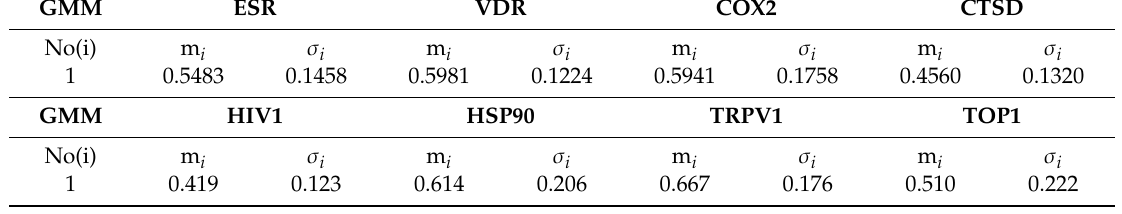
Table 1. Hyperparameters of Q distributions for target classes.